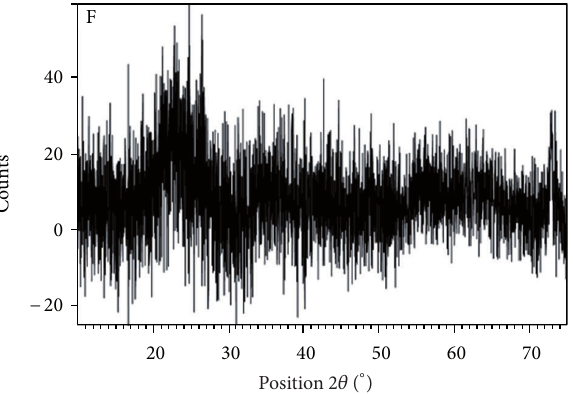
F 2: X-ray diffraction pattern of �uoride adsorbed on